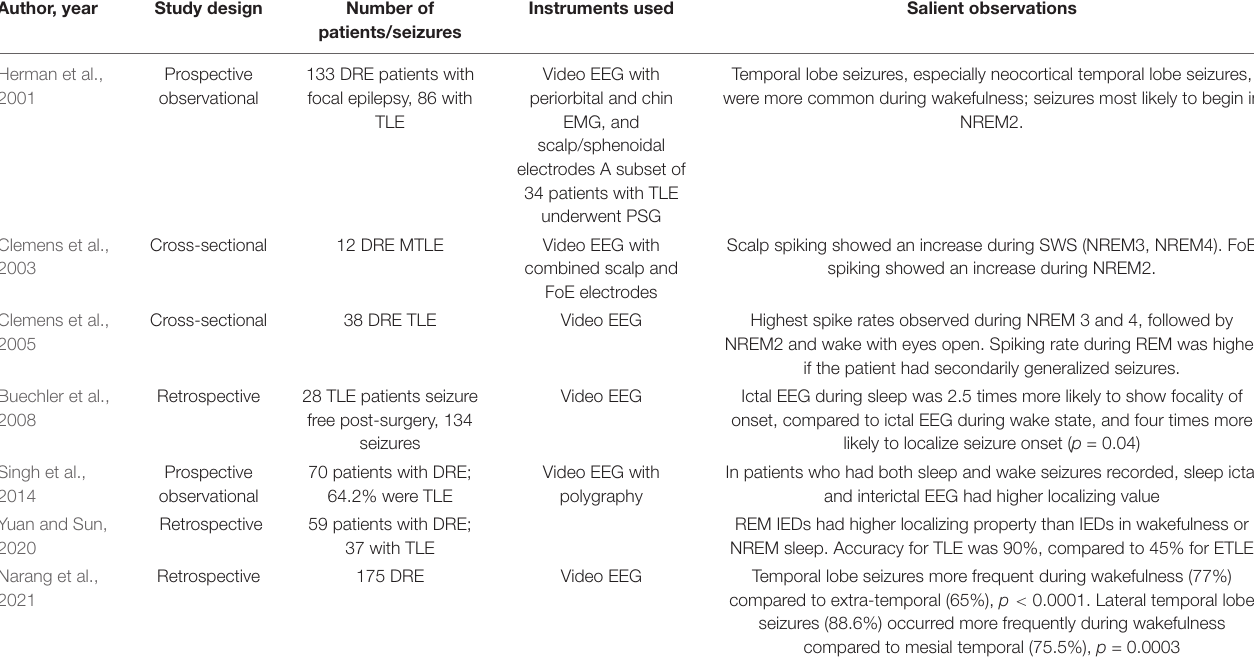
TABLE 1 | Studies assessing localizing properties of sleep in TLE.